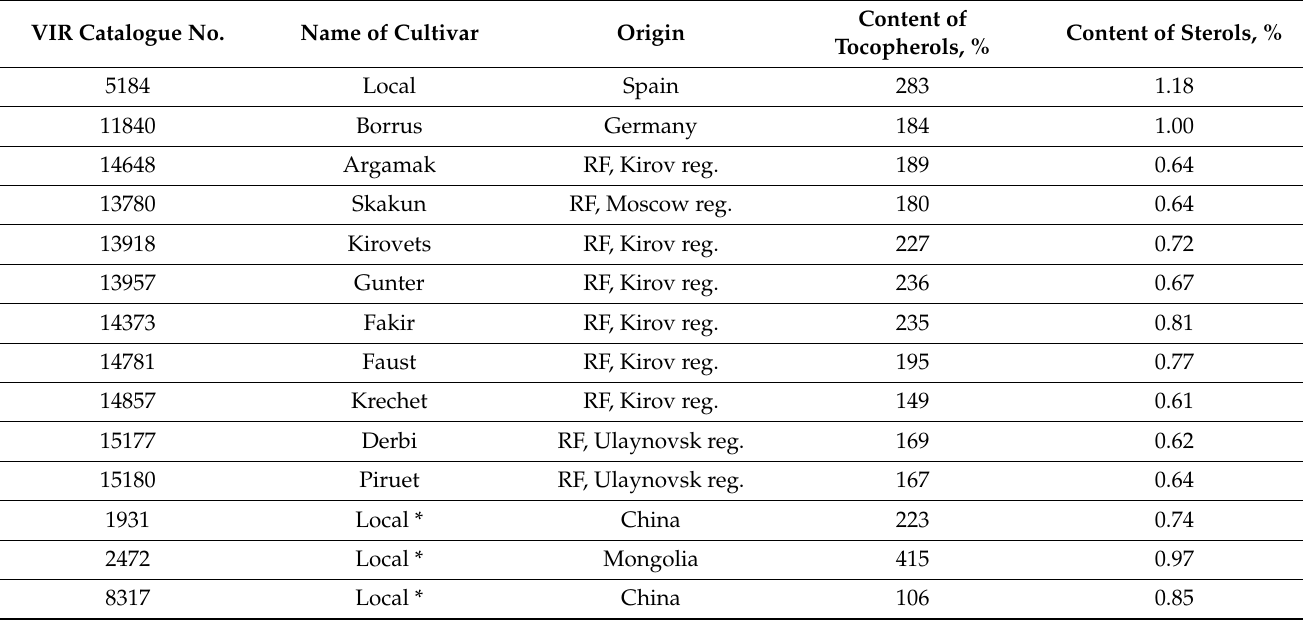
Table 3. Content of tocopherols and sterols in oat accessions.